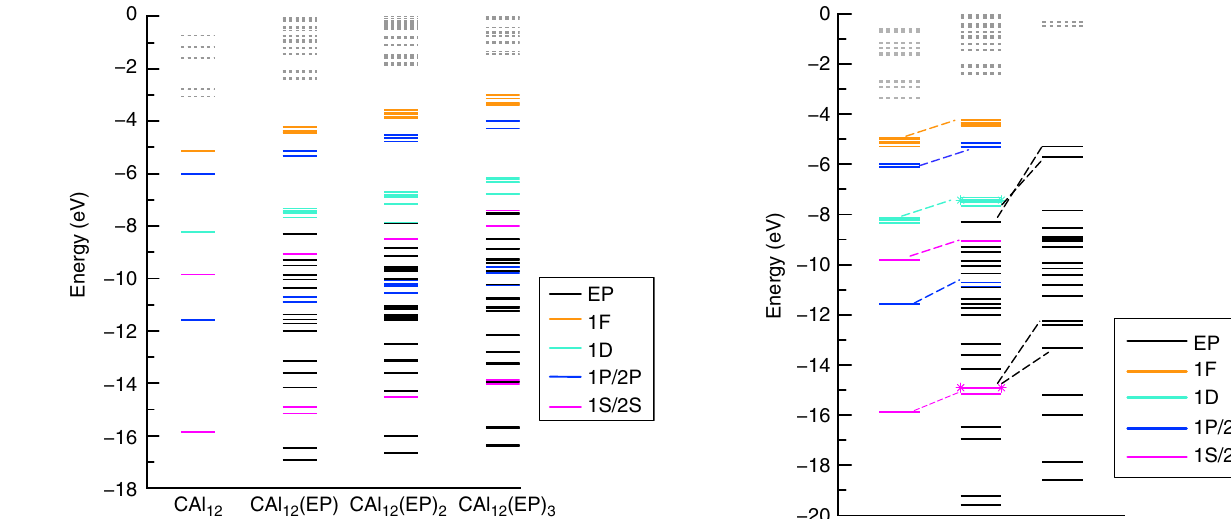
Fig. 5 Electronic properties of ligated Al clusters. a Adiabatic ionization energies of bare Al 13 (EP) n , MAl 12 (EP) n (M = B, C, Si, and P; n = 0 – 3) and b First and second adiabatic ionization energies of bare CAl 12 , CAl 12 (EP) 3 , Al 13 , and Al 13 (EP) 3 clusters. All the values are given in eV